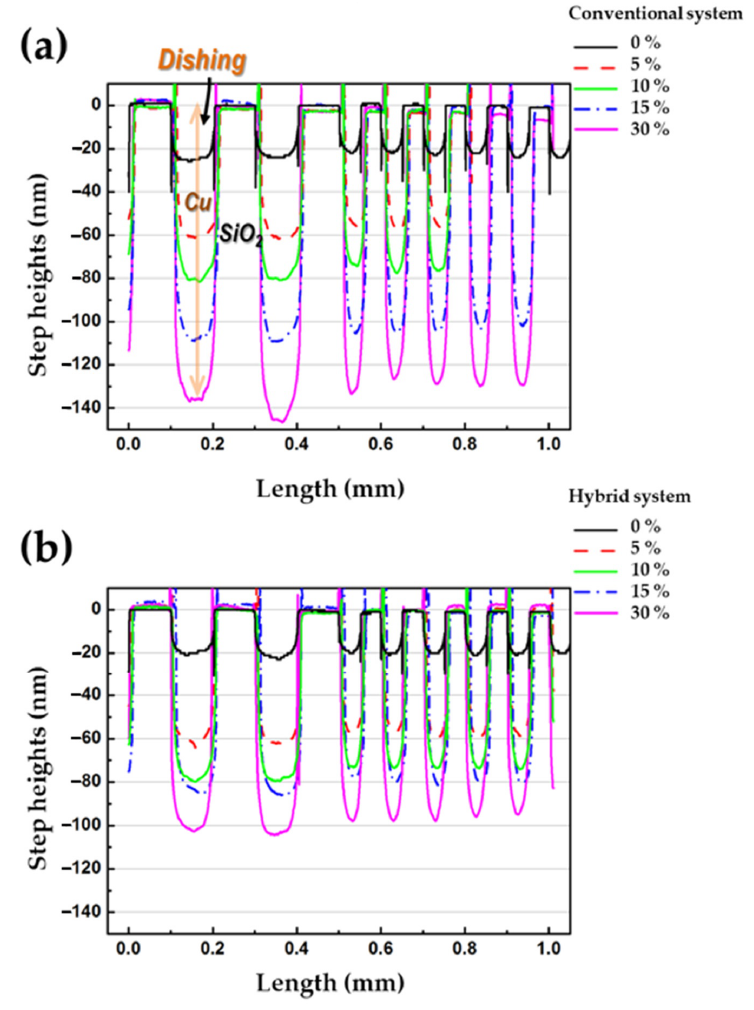
Figure 9. Dishing depth based on the over-polishing time. ( a ) The conventional system and ( b ) the hybrid